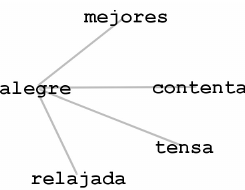
Figure 1. Nearest neighbors of the positive word alegre (cheerful). The negative word tensa (tense) is close in the embedding space to the rest of positive words relajada (relaxed), contenta (glad), and mejores